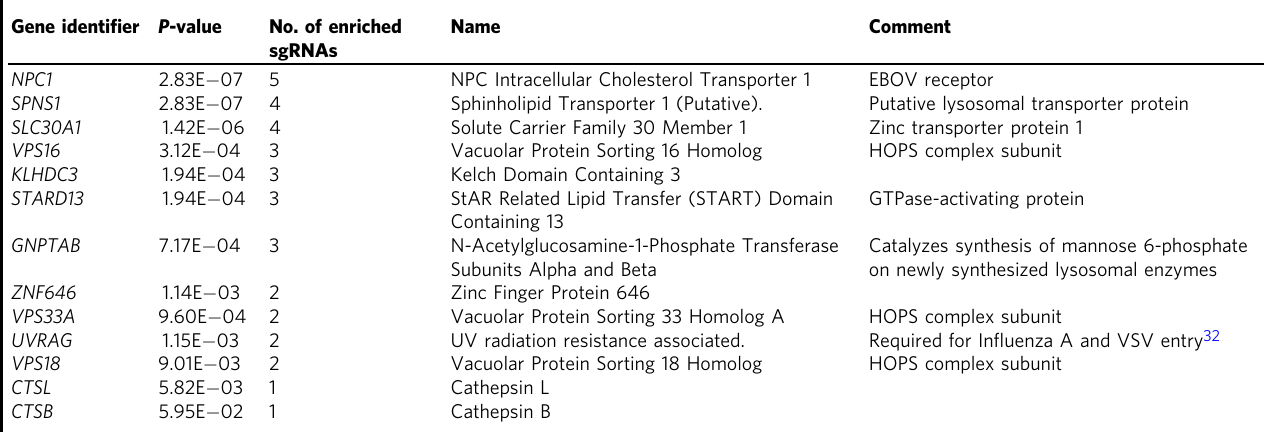
Table 1 Selected hits from the CRISPR-Cas9 screen for genes important for authentic EBOV infection Gene identi fi er P -value No. of enriched sgRNAs